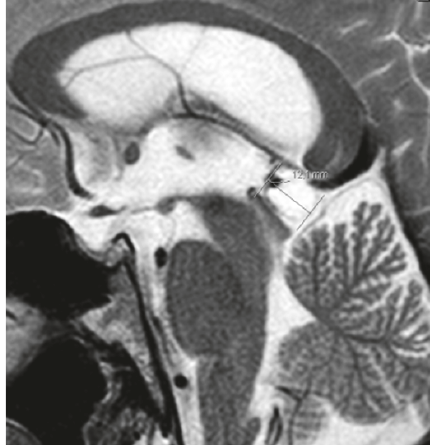
Figure 3: MRI of sella turcica at admission (August 2014): heteroge- neous enlargement with peripheral contrast enhancement.